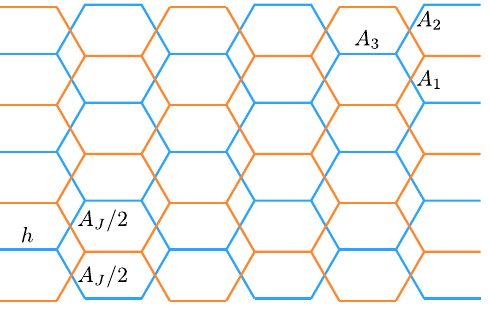
FIG. 4. The 2D model associated with the incommensurate 0 , J ¼ 0 decouples into two interpenetrating TFIM at A h ¼ layers (blue and orange) of a honeycomb lattice. Each hexagonal plaquette is pierced by flux 2 Q . We have adjusted the geometric embedding of the lattice points relative to Fig. 2 in order to emphasize the symmetry associated with rotation by 2 π = 3 . All parallel bonds carry the same coupling magnitude (though the hopping phase depends on the choice of gauge). The incom- mensurate TFIM at J ¼ 0 is embedded into a larger AAA family = 2 , A 2 ¼ A = 2 , A 3 ¼ h on of models with couplings A 1 ¼ A J J bonds as